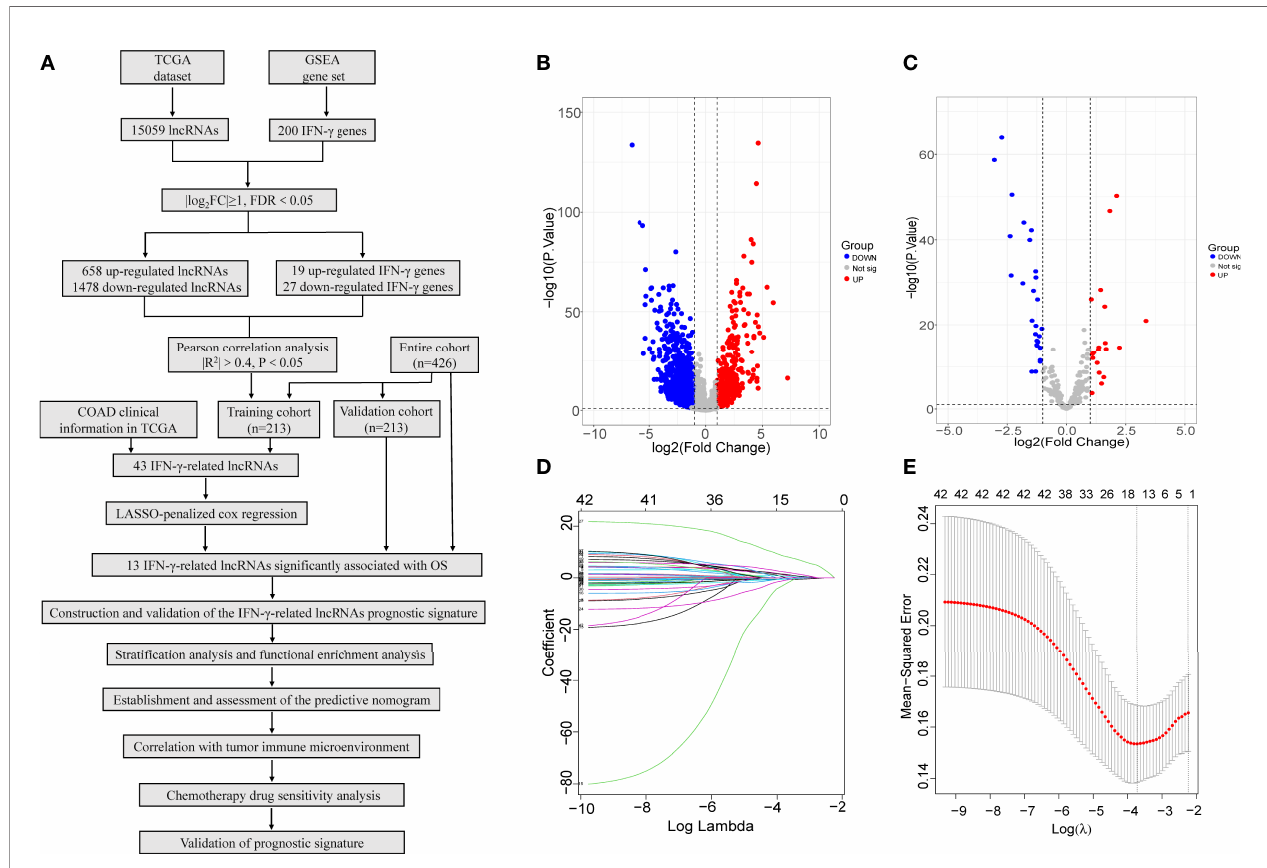
FIGURE 1 | Identi fi cation of IFN- g -related lncRNAs in COAD. (A) Flow chart of this study. (B, C) Among tumour samples and adjacent normal samples, a volcano diagram of differentially expressed lncRNAs (B) and IFN- g related genes (C) . The vertical axis represents -log10 (P value), the horizontal axis represents differential expression multiple log2 (Fold Change), the blue colour indicates downregulated genes, and the red colour indicates upregulated genes. (D) The Least absolute shrinkage and selection operator (LASSO) coef fi cient pro fi le of 13 OS-related lncRNAs and perpendicular imaginary line were drawn at the value chosen by 10-fold cross-validation. (E) The optimal tuning parameter (log l ) of prognostic IFN- g -related lncRNAs were selected to cross-validation the error curve. The vertical axis is the mean-squared error, and the horizontal axis is log l . The dotted vertical lines were plotted at the optimal value in accordance with the minimal criterion and 1-se